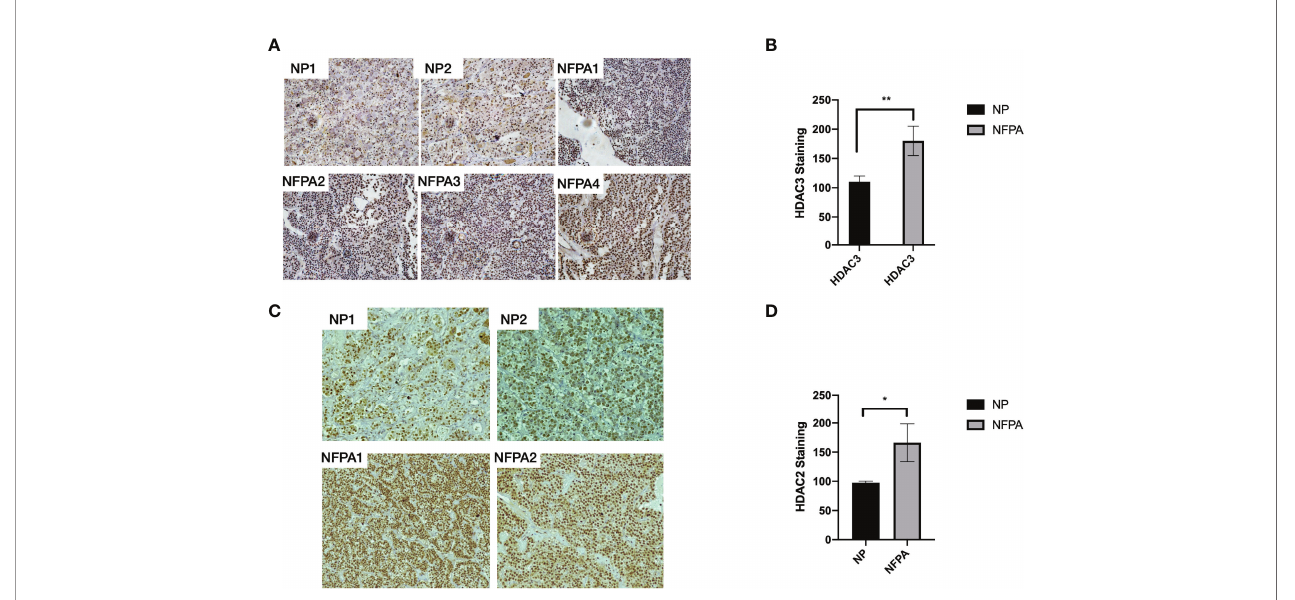
FIGURE 2 | HDAC3 protein staining in normal human pituitaries and NFPAs. (A) Representative immunohistochemical staining images of HDAC3 protein in 2 NPs and 4 NFPAs. (B) HDAC3 immunostaining was quanti fi ed on the basis of color intensity of converted photos (40x) to a subtractive color model CMYK and split into green/red/yellow/ blue channels. The intensities were averaged from 100 selected nuclei. (C) Representative immunohistochemical staining images of HDAC2 protein in 2 NPs and 2 NFPAs. (D) HDAC2 immunostaining was quanti fi ed on the basis of color intensity of converted photos (40x) to a subtractive color model CMYK and split into green/red/yellow/blue channels. The intensities were averaged from 100 selected nuclei. NP, normal pituitary; NFPA, non-functioning pituitary adenoma; *P < 0.05; **P < 0.001.